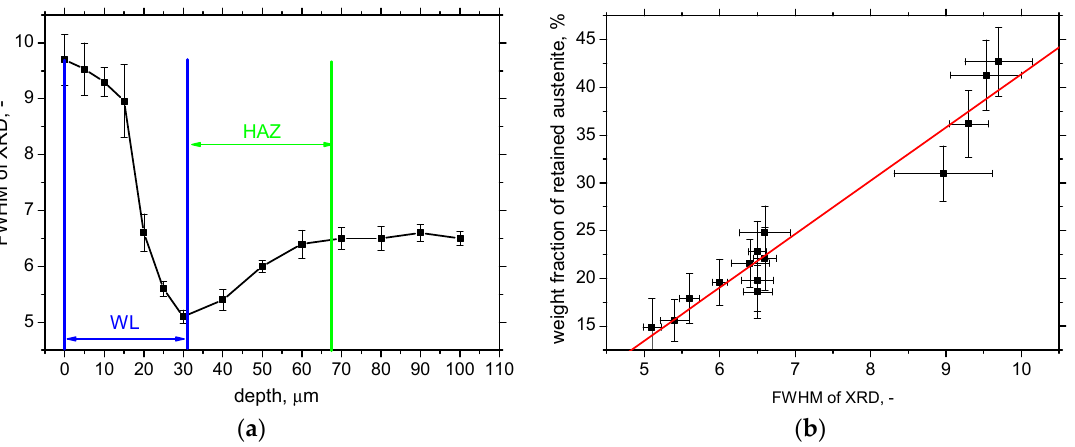
Figure 11. Depth profile of FWHM for VB = 0.8 mm and cutting speed 100 m.min − 1 and its correlation with austenite fraction (bulk FWHM 6.5 ± 0.12): ( a ) depth profile of FWHM ; ( b ) FWHM versus austenite fraction (correlation coefficient 0.97).